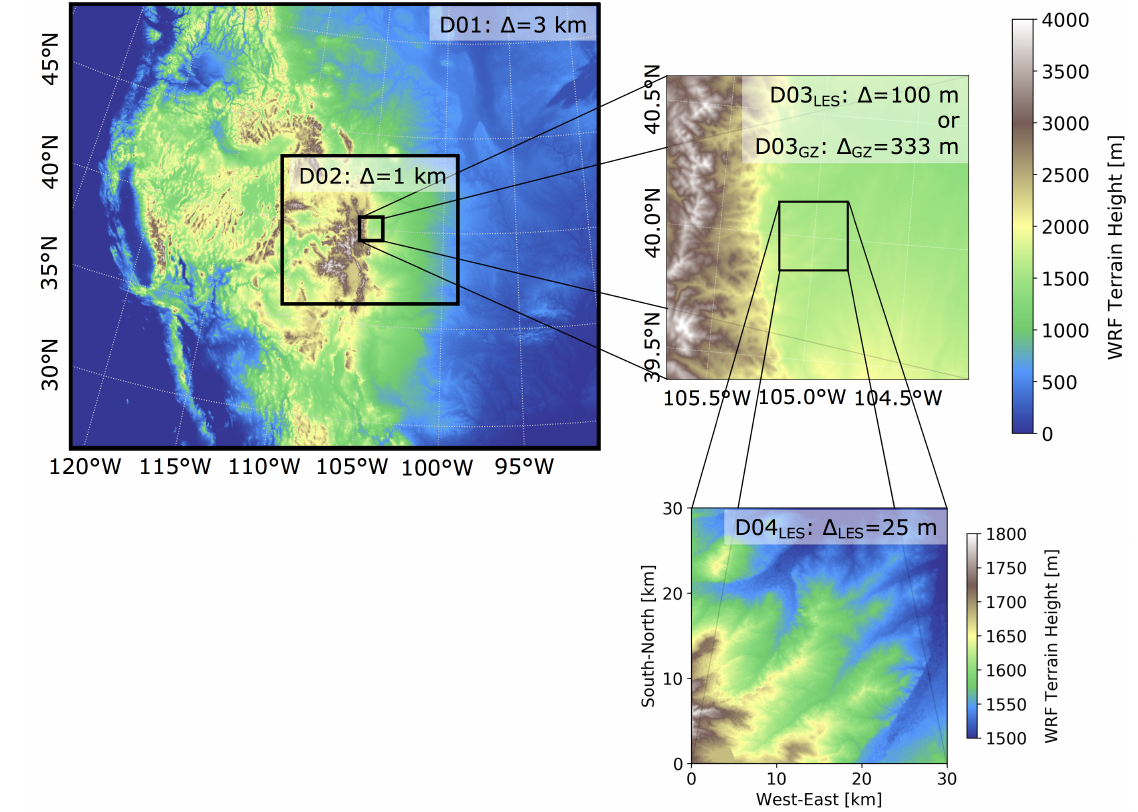
Figure 1. Simulation domains used. The first two domains (D01 and D02, shown on the left) are the same for all simulations performed. The third largest domain (D03) is approximately the same extent for both simulations, but two different horizontal grid spacings are used: ∆ GZ = 333 m for gray-zone simulations and 100 m for the reference simulation RLES. The fourth domain (D04) has a grid spacing of ∆ LES = 25 m and is only included in the RLES